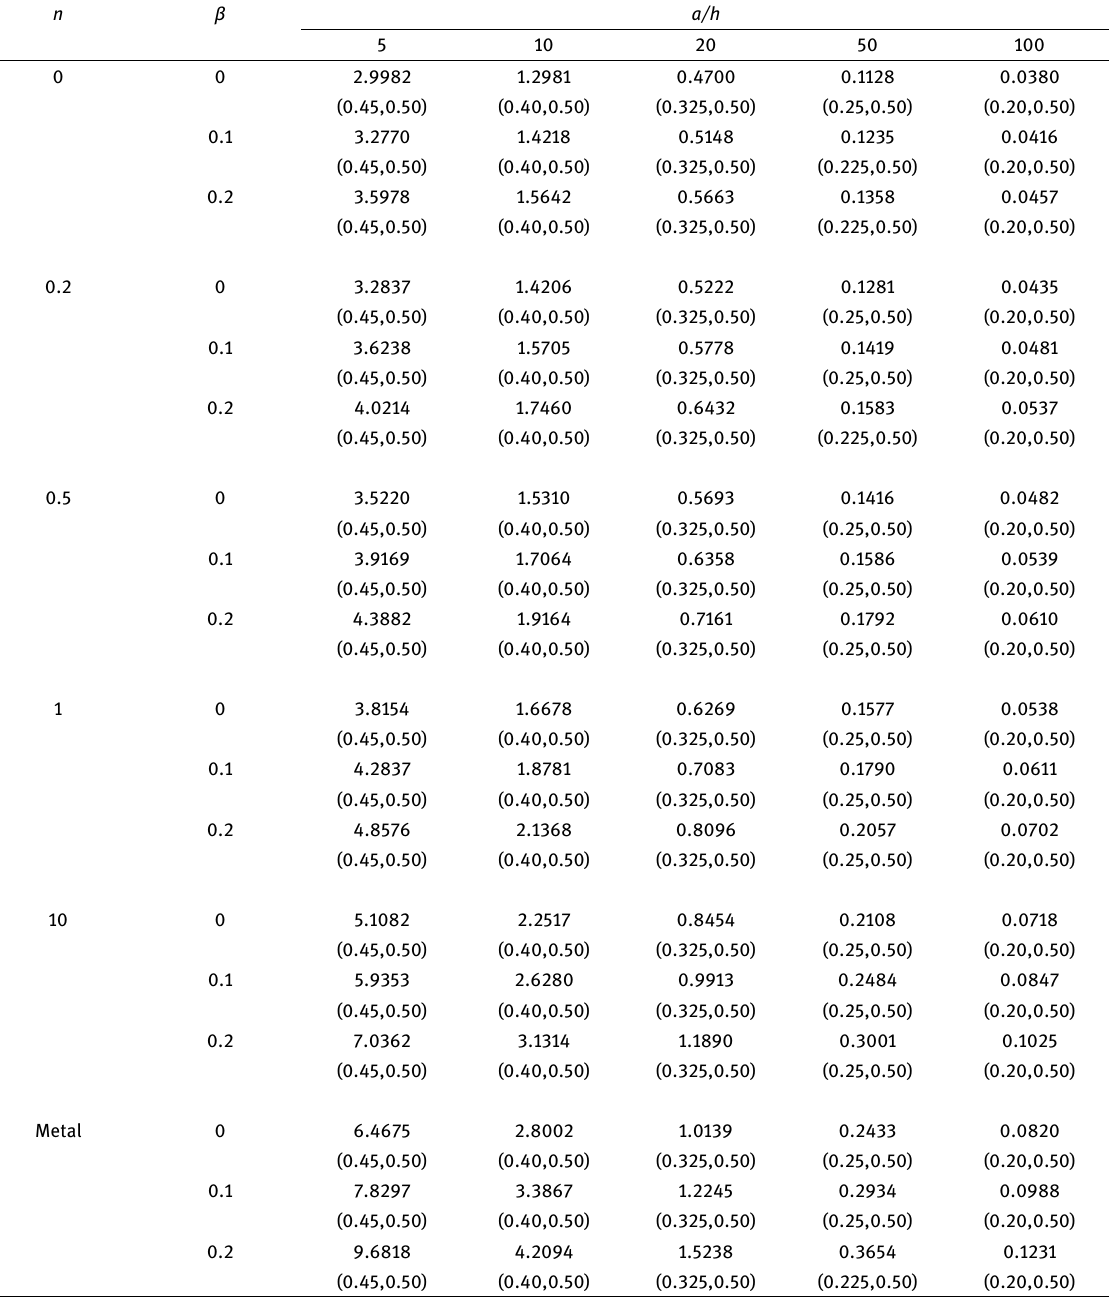
Table 5: Variation of non-dimensional deflection of simply supported FGM porous conoidal shell subjected to uniform